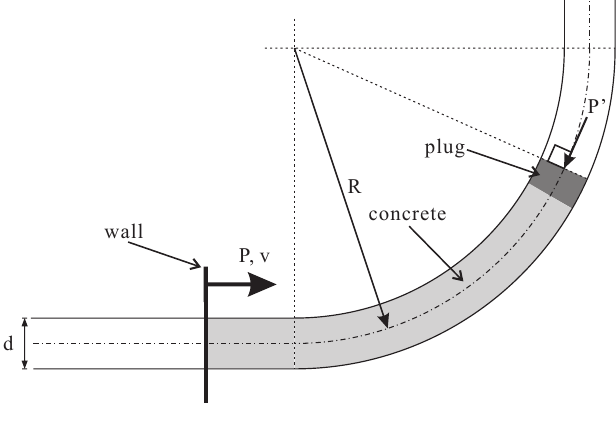
Figure 7. Illustration of pumping